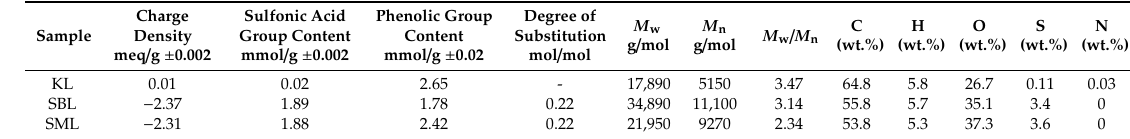
Table 1. Properties of KL, SBL, and SML.